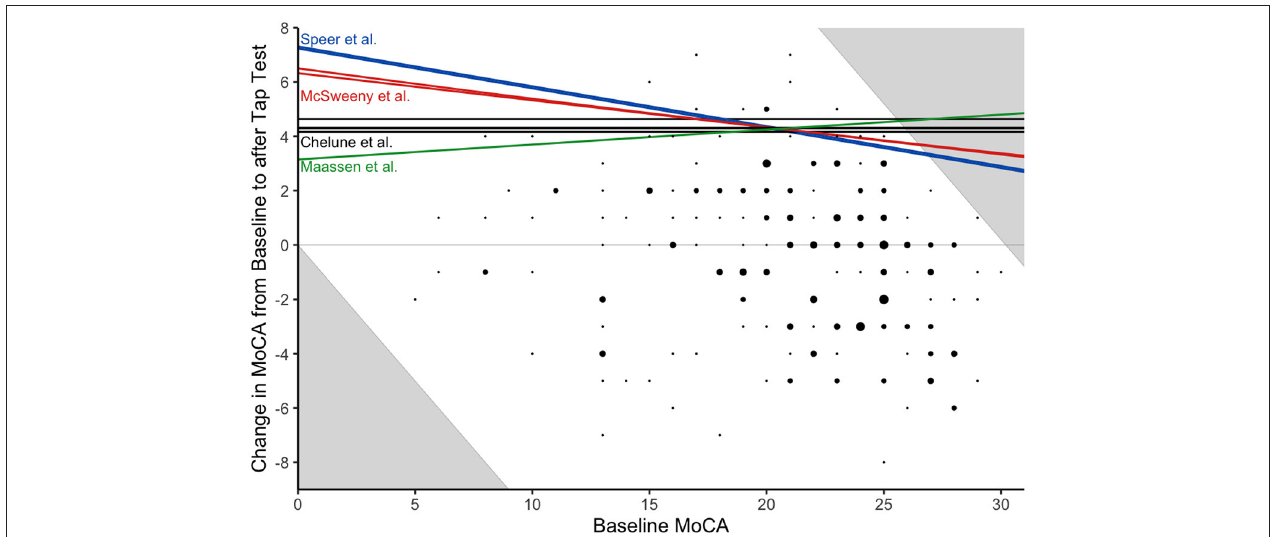
FIGURE 3 | Comparison of Changes in the Montreal Cognitive Assessment to Multiple Reliable Increase Thresholds. Thresholds for all nine reliable change methods are overlaid on the data. The choice of slope formula for the reliable change threshold was more consequential than the choice of intercept formula. Hence, each reliable change threshold is given the color corresponding to the slope formula used (i.e., Speer, McSweeny, Chelune, or Maassen et al.). Since MoCA is a discrete measurement and overlapping points were common in the scatterplot, the size of the point indicates the number of participants with that particular (x, y) combination.